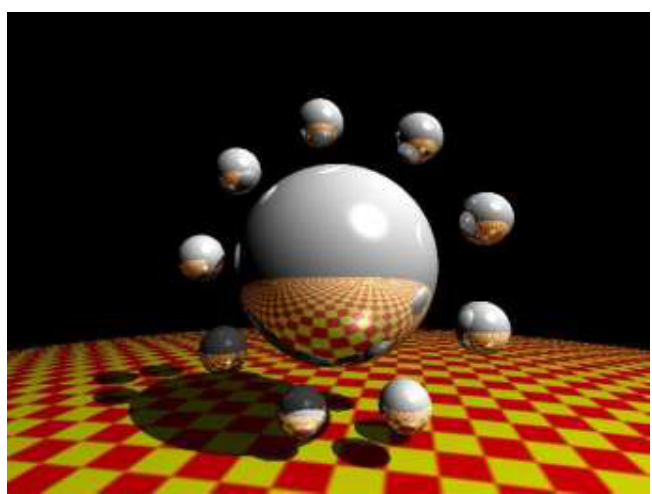
Figure 1. Raytrace Technique (https://en.wikipedia.org)